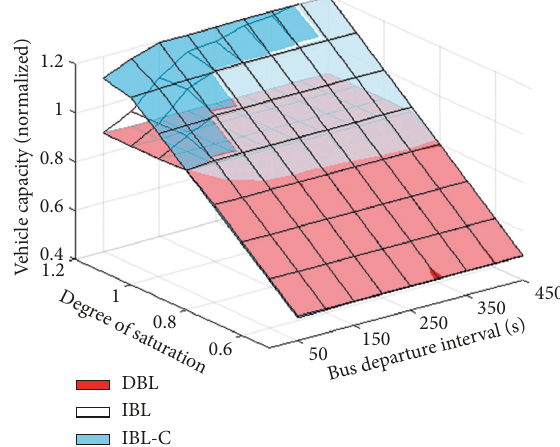
Figure 12: Traffic flow volume with near-side bus stop.